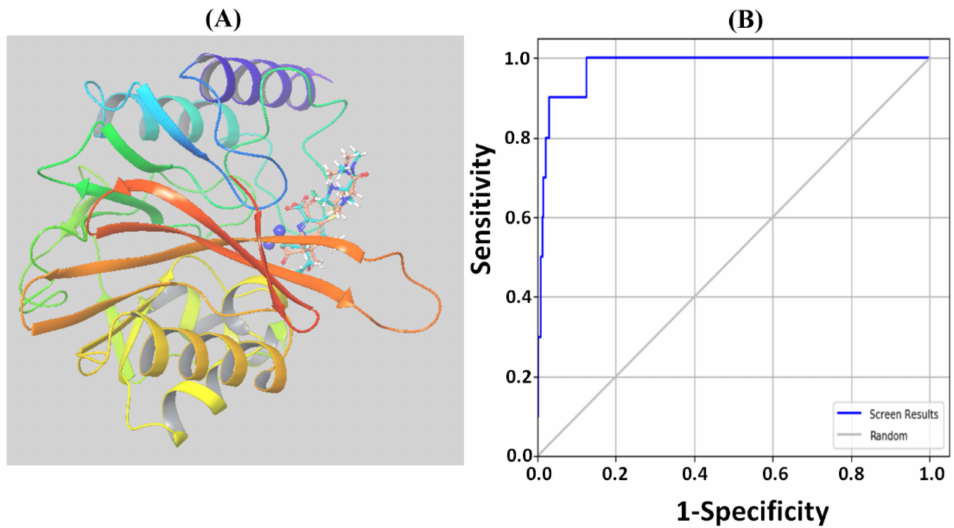
Figure 1. Validation of the molecular docking protocol: ( A ) Re-docking of the ligand present in the X-ray crystal structure to the active site of NDM-1, and calculation of the root-mean-square deviation (RMSD) between the docked pose and the crystal structure pose of the ligand. The RMSD between the two poses was 0.7634 Å. ( B ) Receiver operating characteristic (ROC) curve displaying the sensitivity and specificity of the docking